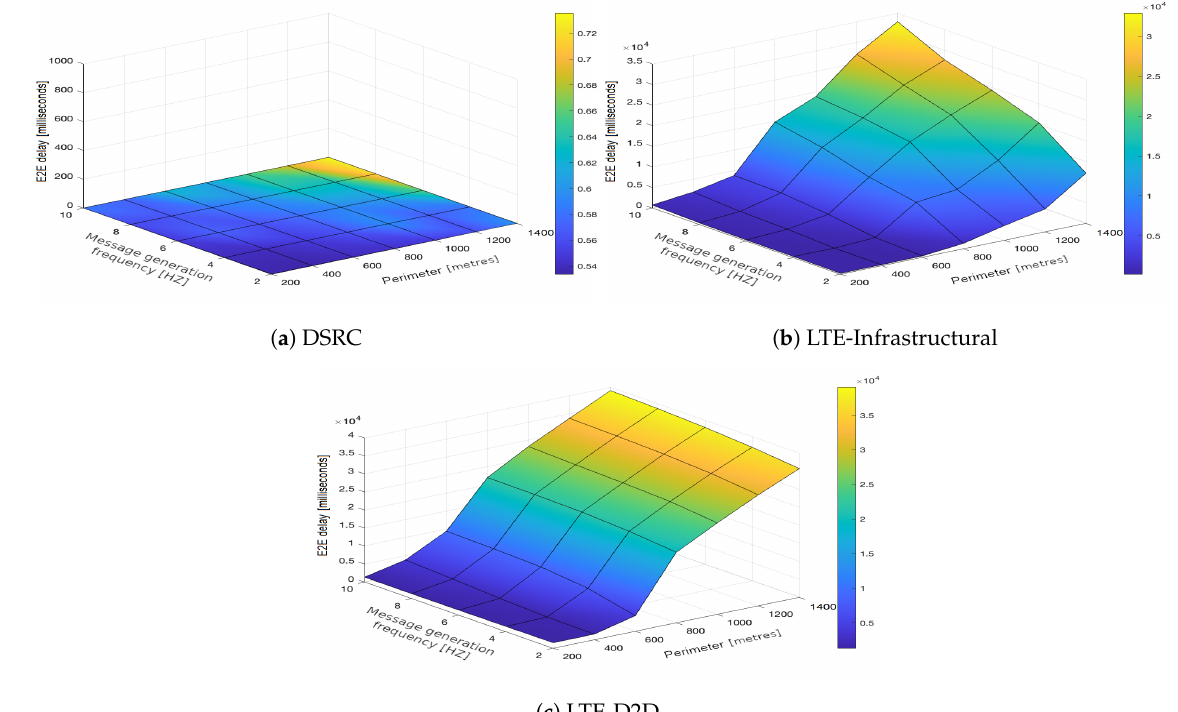
Figure 11. End-to-end delay obtained for the traffic intensity of 1000 vehicles per hour.